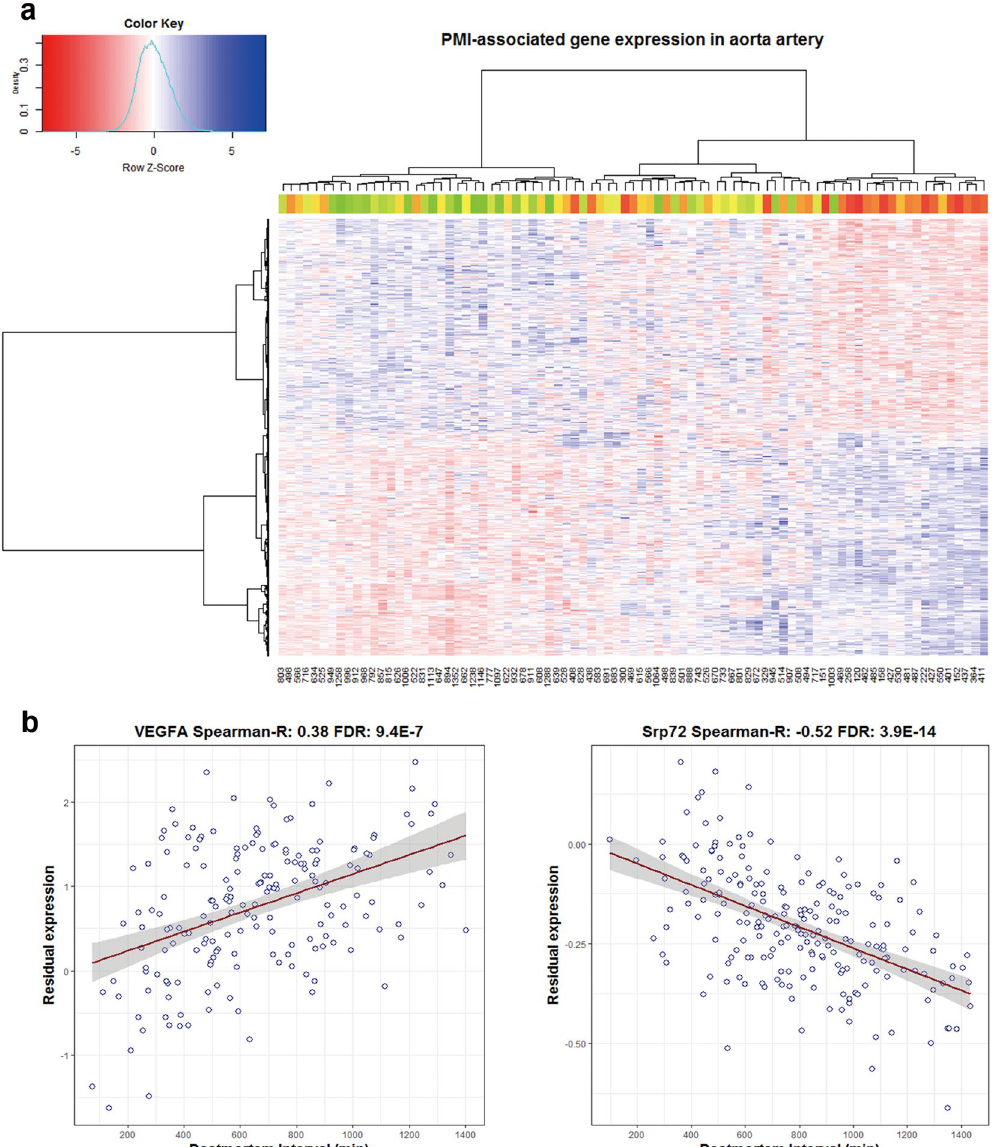
Figure 2. Visualization of gene expression associated with PMI. ( a ) Heat map of 1,413 PMI-associated genes (row) on 85 samples (column). Colors represent residual gene expression values with red for low expression and blue for high expression. The PMI of each individual is displayed at the bottom and also illustrated in color bar at the top with color changes from red to green with PMI increased. ( b ) Scatter plot of two representative PMI-associated gene expression patterns of VEGFA and Srp72 in whole blood and muscle skeletal respectively. The dots represent the expression of samples. Spearman-R value in the title represents the Spearman correlation coefficient of gene expression and PMI across all